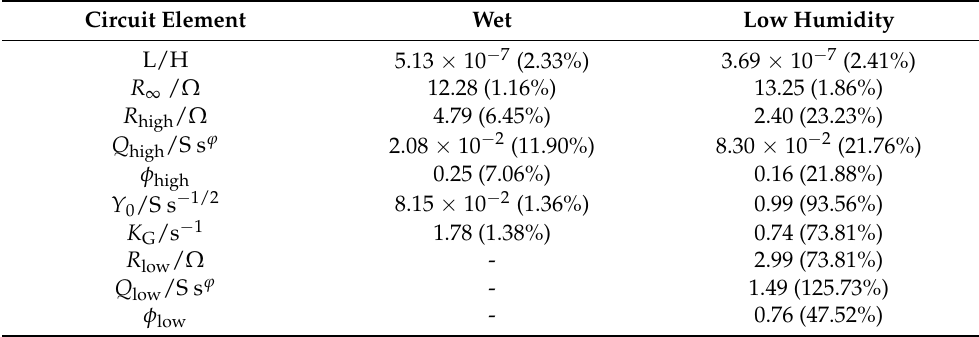
Table 1. Fitting results using the equivalent circuit model (EQM) model (error % inside parenthesis) to the data obtained at 450 ◦ C in O 2